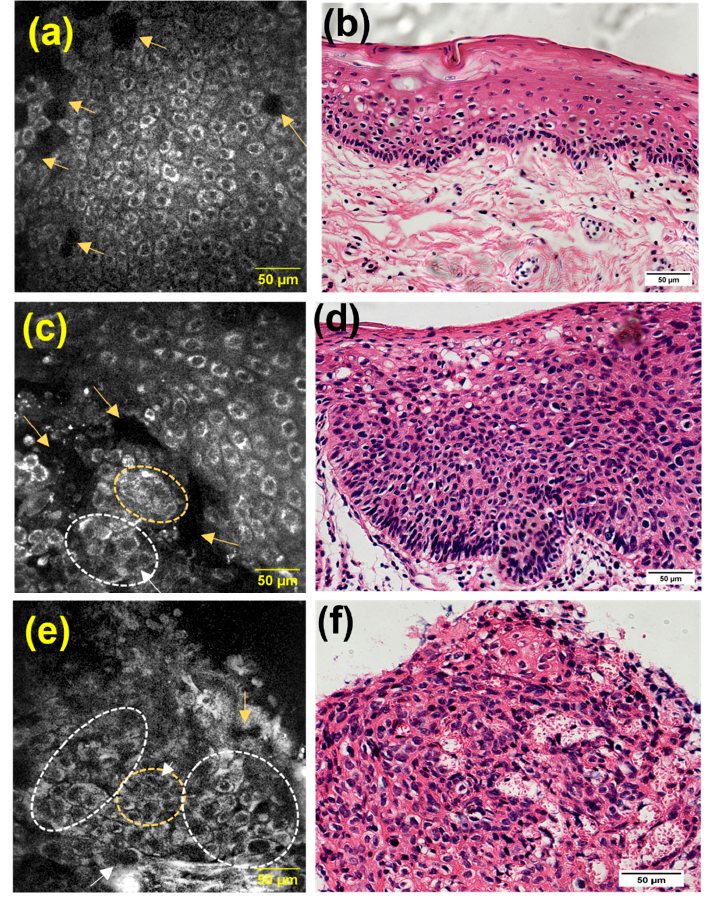
Figure 5. MPAM visualization of an intact FOM tissue. An organized, uniform cellular pattern can be seen in panel ( a ) and is also evident in corresponding histology ( b ). In a neighboring site graded as a dysplastic site ( c , d ), cytologic atypia and cellular discohesions are visible. Full fields of cellular abnormalities were found in an adjacent area to that of the dysplastic site ( e , f ). For example, cellular discohesion (indicated by yellow arrow) and anisonucleosis (indicated by the white circle) can be seen in all gradings. Overcrowding (indicated by yellow circle) and multinucleated cells (indicated by white arrow) can be observed in the dysplastic and SCC graded sites. Microscopy FOV 321 × 321 µm. Histology was imaged with Obj. 20×, 0.4 NA Scale: 50 µm. A variety of additional features and cell types (e.g., infiltrating inflammatory cells)